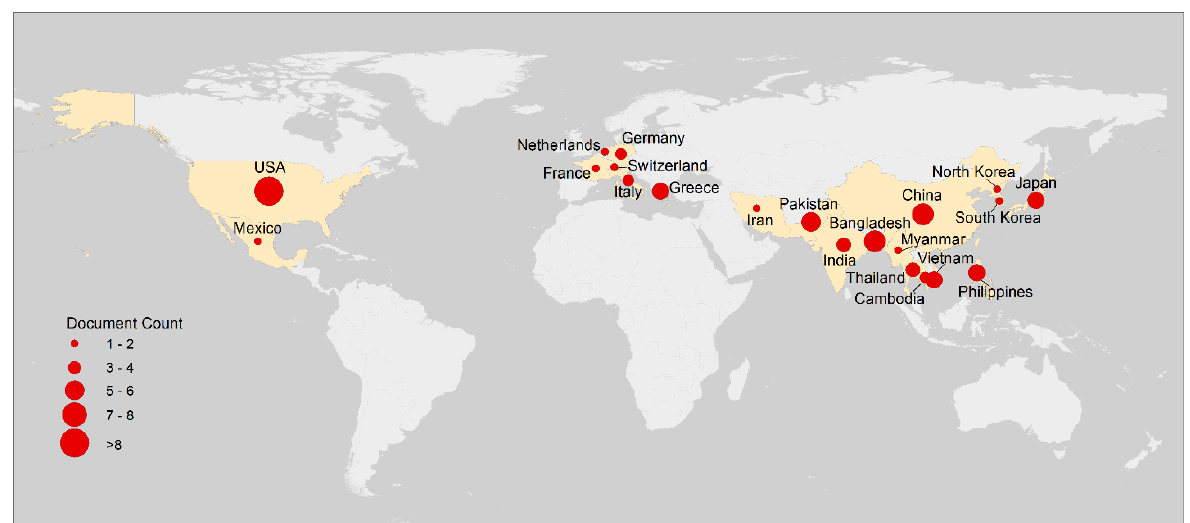
Figure 5. Spatial distribution of case studies.